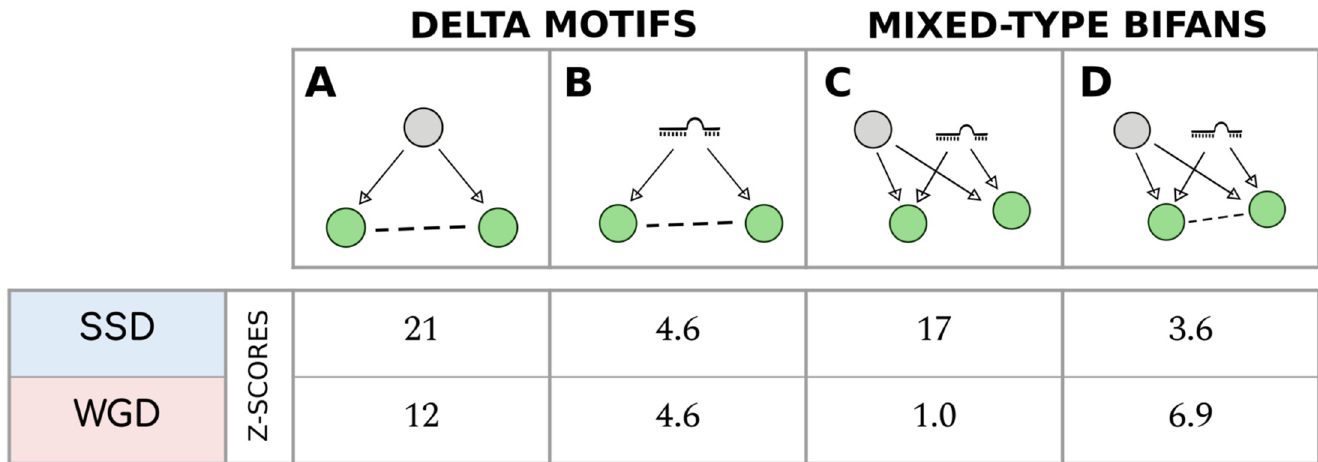
Fig 10. Motifs with mixed-type regulatory interactions. (A) Transcriptional Δ motifs. (B) miRNA-mediated Δ motifs. (C) Mixed Bifan motifs, in which a pair of target genes are regulated both by a common TF and a common miRNA. (D) Mixed Bifan motif in which the two target genes interact at the protein level. The reported Z-scores are referred to the null model obtained by randomizing the transcriptional regulatory network (apart from the miRNA Δ motif for which the miRNA-gene network is randomized).